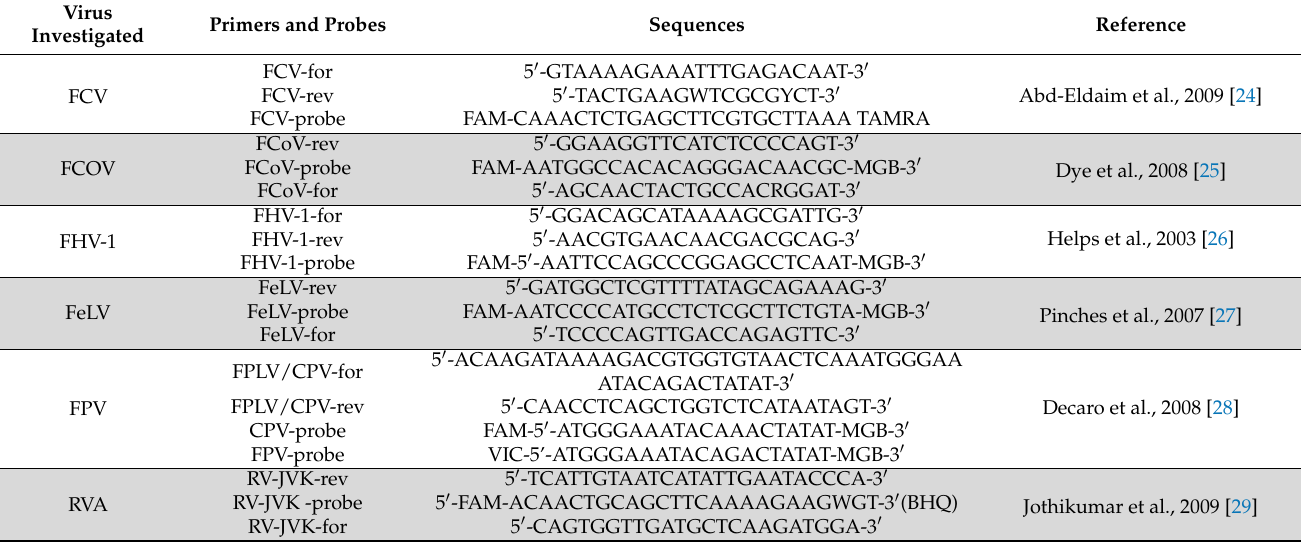
Table 1. Primers and probes employed in the Real-Time PCR